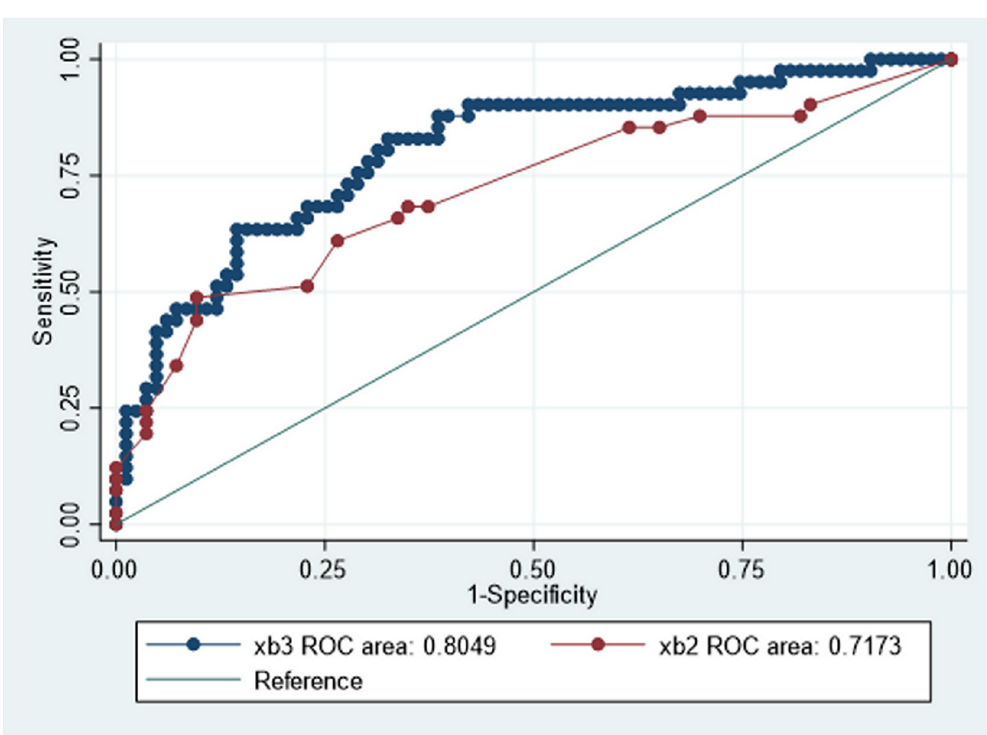
Fig 4. Comparison of discriminatory performance using ARISCAT vs. Model 1 for predicting PPCs. The red line represents the ROC for ARISCAT. The dark blue line represents the ROC for Model 1. The light blue line represents the reference line. Model 1 was derived using multivariable analysis incorporating the ARISCAT score, age, and 24-hour opioid consumption/kg. AUROC for ARISCAT was 0.717 (95% CI 0.616–0.819), and AUROC for Model 1 was 0.805 (95% CI 0.721–0.889). Comparisons between the two ROC curves were statistically significant (p = 0.016). ARISCAT = Assess Respiratory Risk in Surgical Patients in Catalonia. PPCs = postoperative pulmonary complications, as defined by Canet et al. [25]; ROC = receiver operating characteristic; AUROC = area under receiver operating